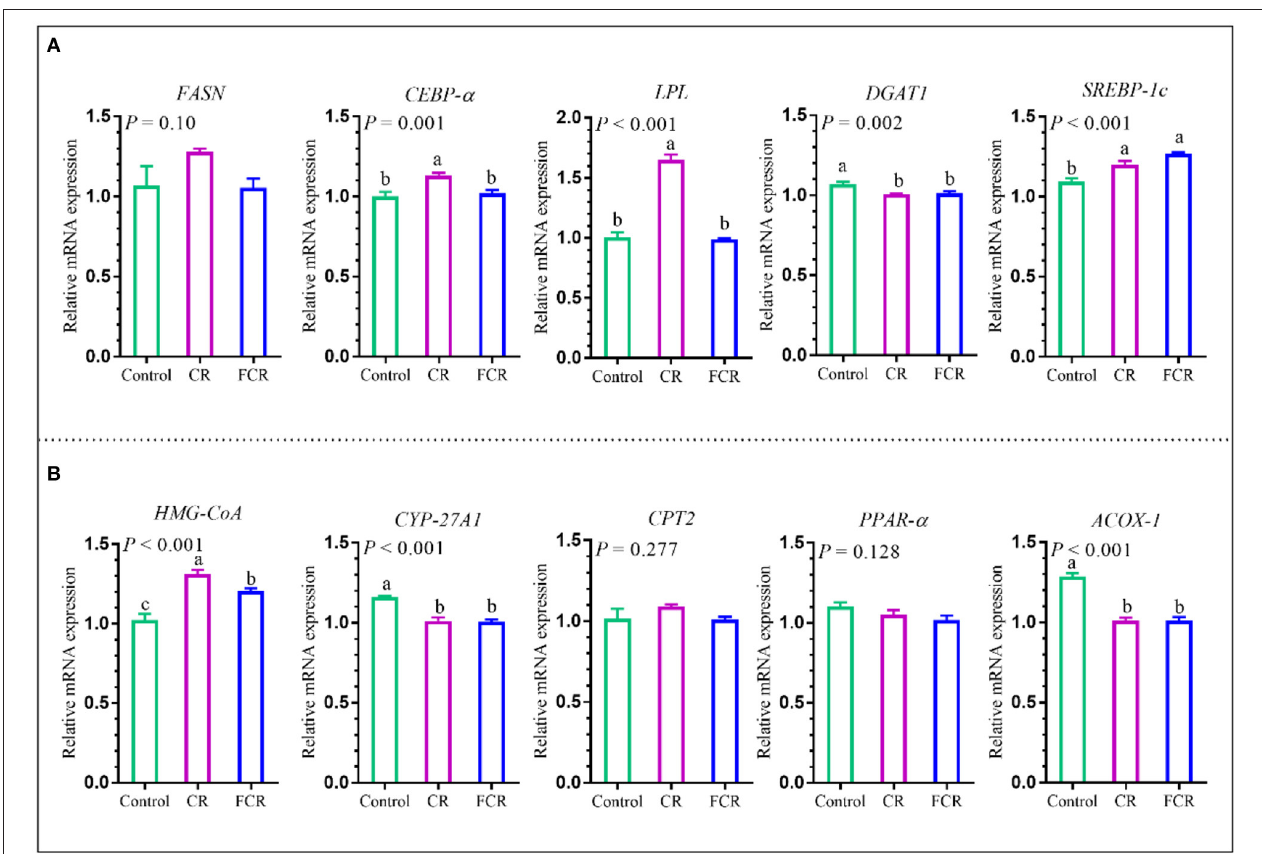
FIGURE 6 | Effects of cassava residue (CR) or fermented cassava residue (FCR) on hepatic lipid metabolism of piglets. The mRNA expression levels of enzymes associated with fatty acid synthesis and triglyceride metabolism (A) and cholesterol metabolism (B) . The data are presented as the means ± SEM, and values with different letters mean significant difference ( P < 0.05). ACOX-1 , acetyl-CoA oxidase 1; CEBP- α , CCAAT enhancer-binding protein alpha; CPT2 , carnitine palmitoyl transferase 2; CYP-27A1 , cytochrome p540 family 27 sub-family A member 1; DGAT1 , diacylglycerol-o-acyltransferase 1; FASN , fatty acid synthase; HMG-CoA